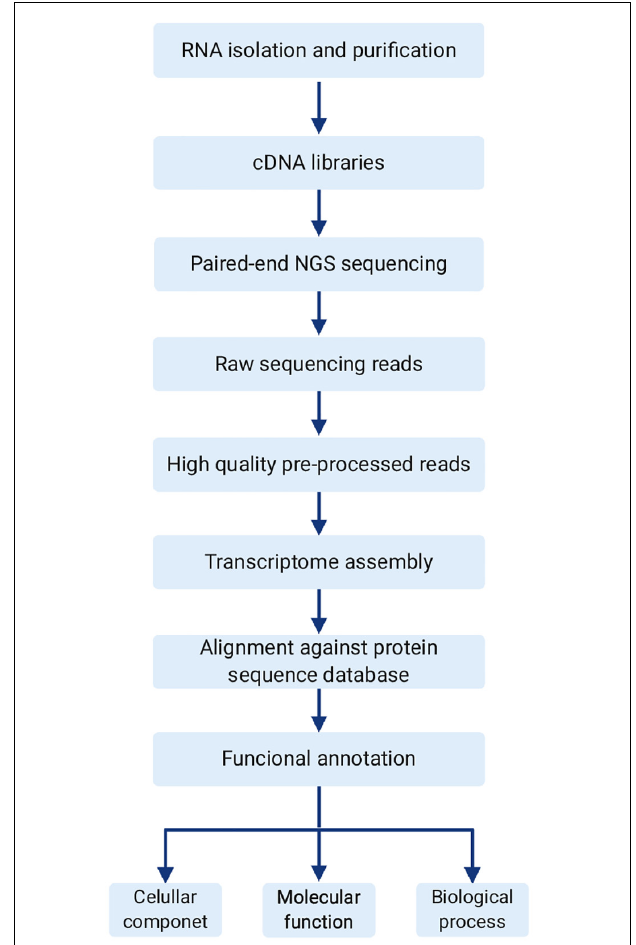
FIGURE 3 | General transcriptome pipeline. The workflow typically starts with total RNA extraction and purification. Then the cDNA library is constructed using an appropriate kit, prior to NGS paired-end sequencing. Next is pre-processing of raw data in order to obtain high quality reads for transcriptome assembly. Finally, assembled transcripts are aligned to a protein database of choice, and functionally annotated.